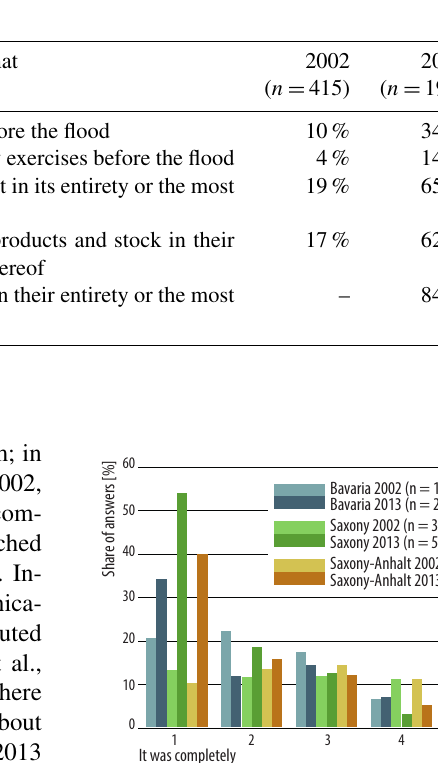
Table 4. Information by the company respondents from Saxony on their preparedness for and the effectiveness of emergency measures implemented.